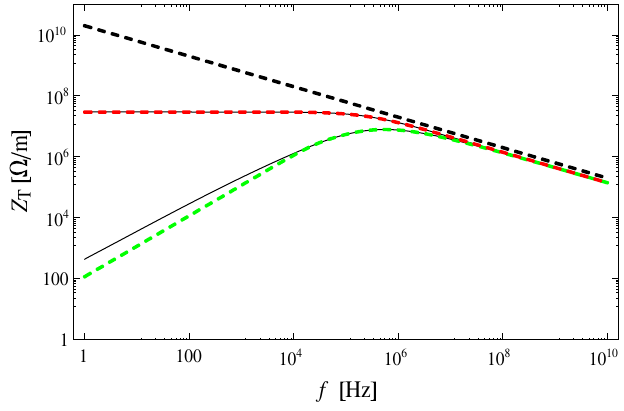
FIG. 5. Transverse coupling impedance in the ultrarelativistic limit for the 1 m long LHC graphite collimator, having inner and outer radii b ¼ 2 mm and r o ¼ 25 mm , and the conductivity (cid:4) ¼ 7 (cid:1) 10 4 = (cid:3) m . The real and imaginary values are shown, respectively, as dashed green and red curves. Also shown are the impedances for an unbound graphite collimator (black) and the absolute value of the classic thick wall approximation (dashed black).